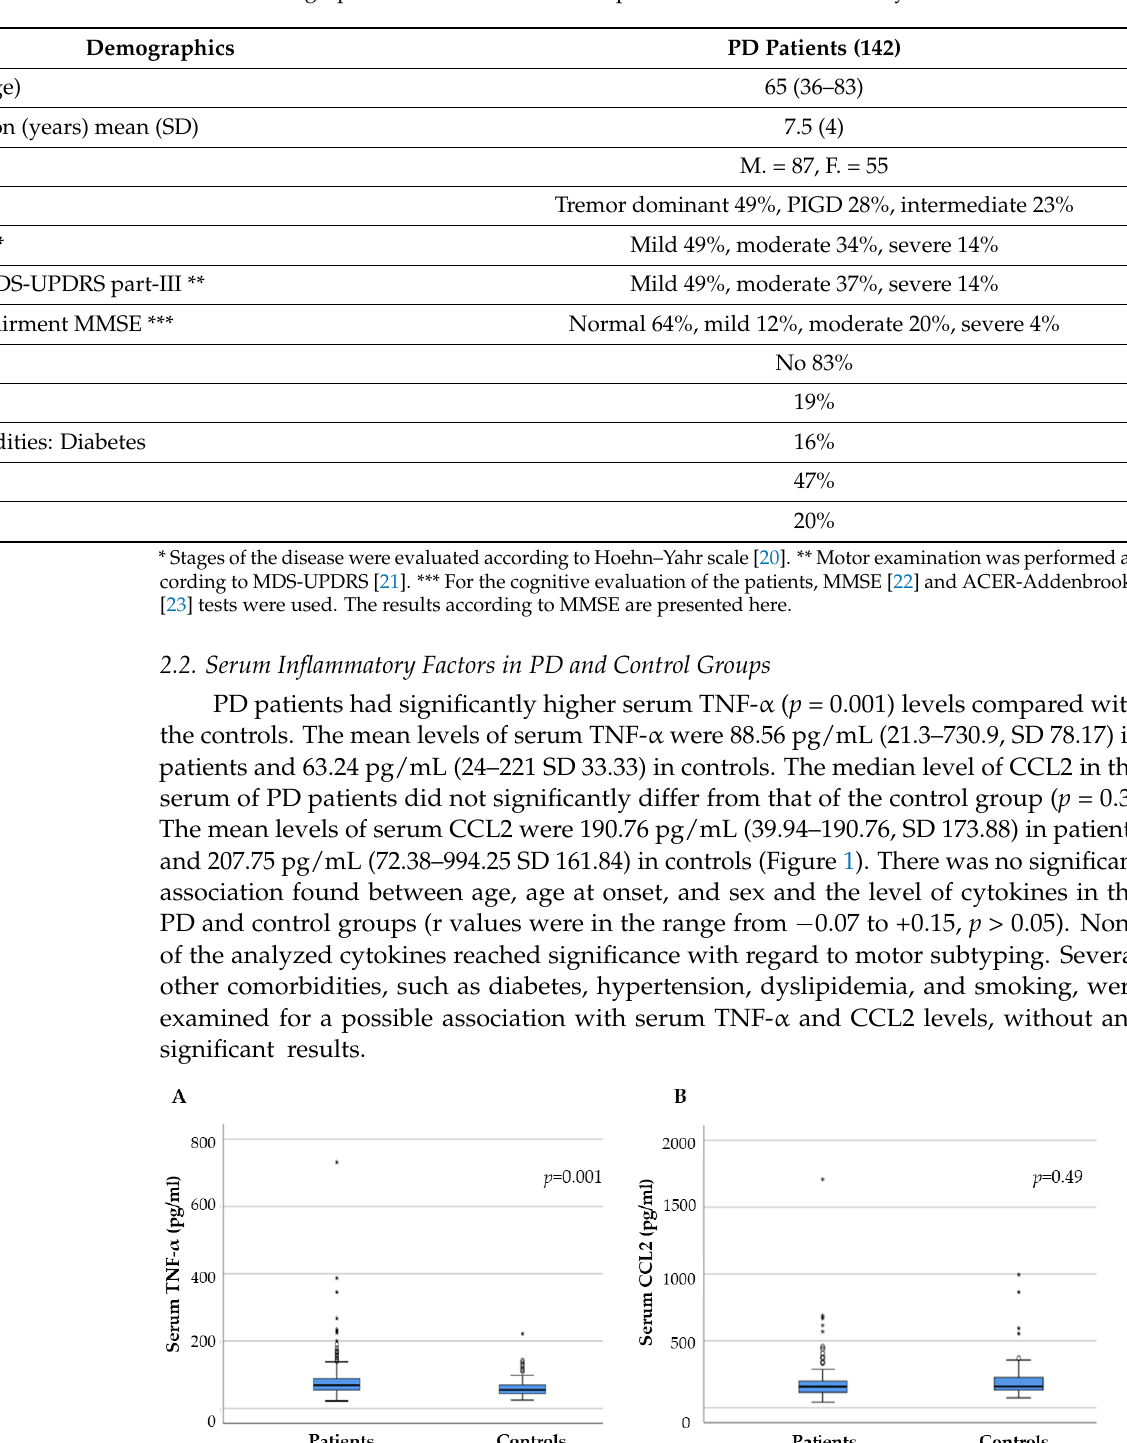
Table 1. Demographic and clinical data of PD patients enrolled in the study.